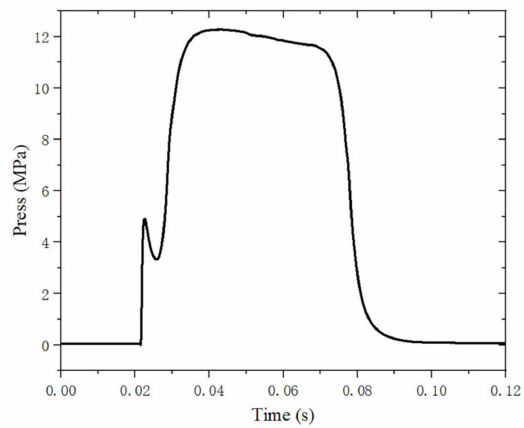
Figure 4. Variation of pressure with